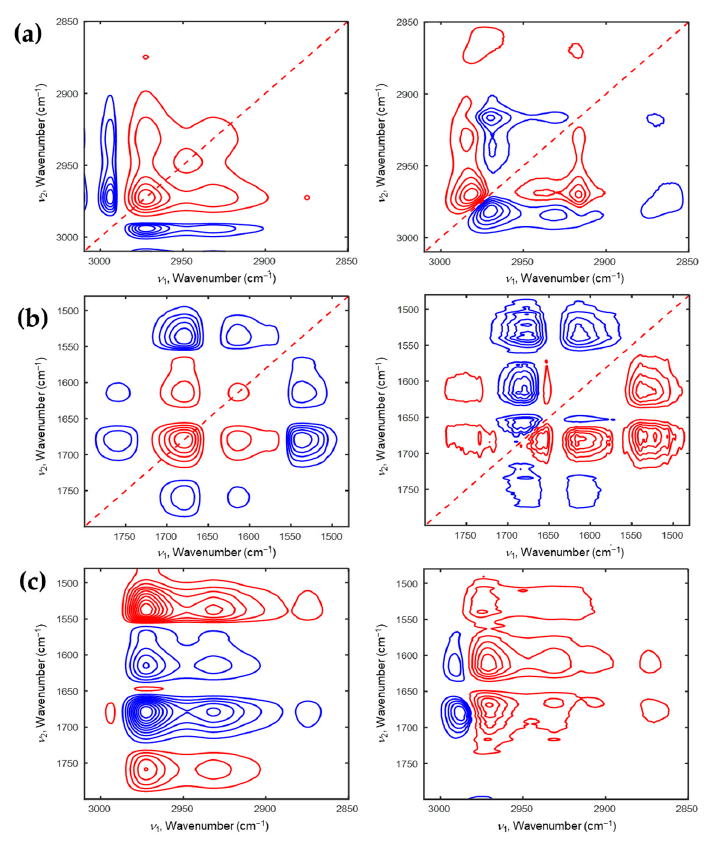
Figure 5. 2D correlation spectra of P(NiPAAm- co -AAc) hydrogel of pH2 during the heating process ( a : 3010–2850 cm − 1 , b : 1800–1480 cm − 1 ). Hetero-mode 2D correlation spectra ( c ) of P(NiPAAm- co -AAc) hydrogel during the heating process for the 3010–2850 cm − 1 and 1800–1490 cm − 1 regions.